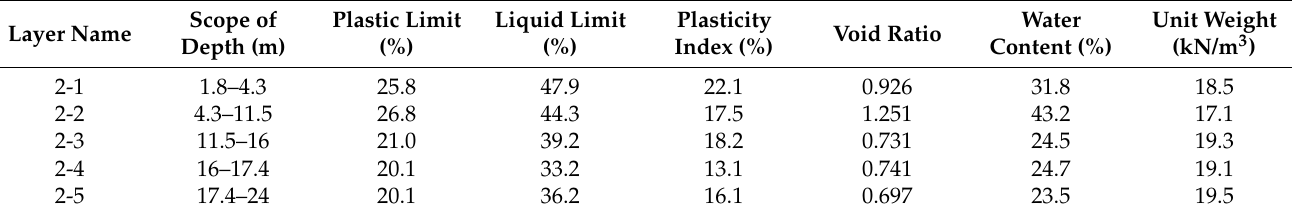
Table 1. Basic physical and mechanical properties of each soil layer.